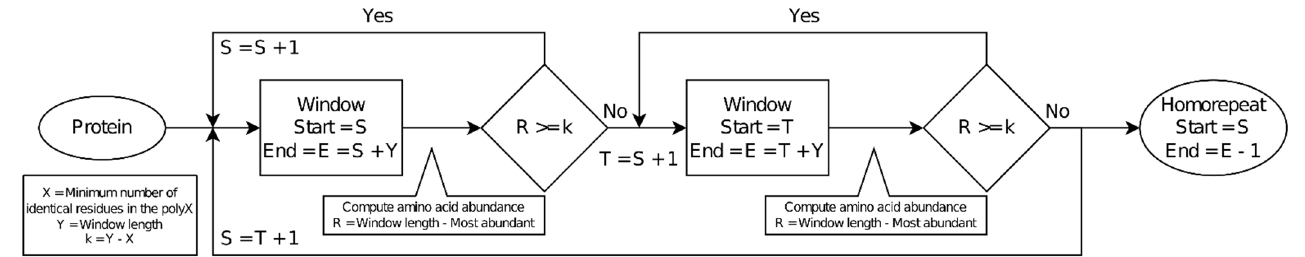
Figure 1. PolyX2 workflow.